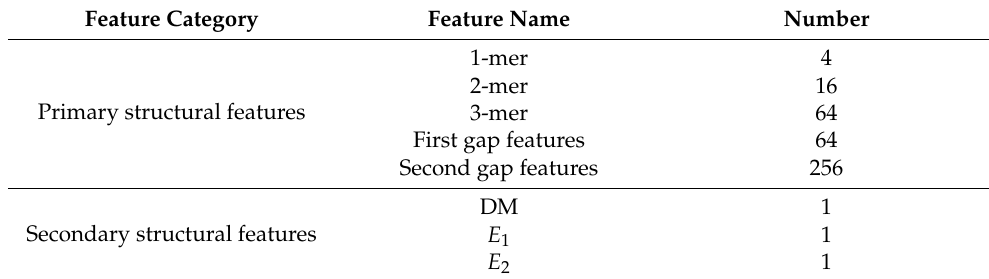
Table 3. Information on structural features.